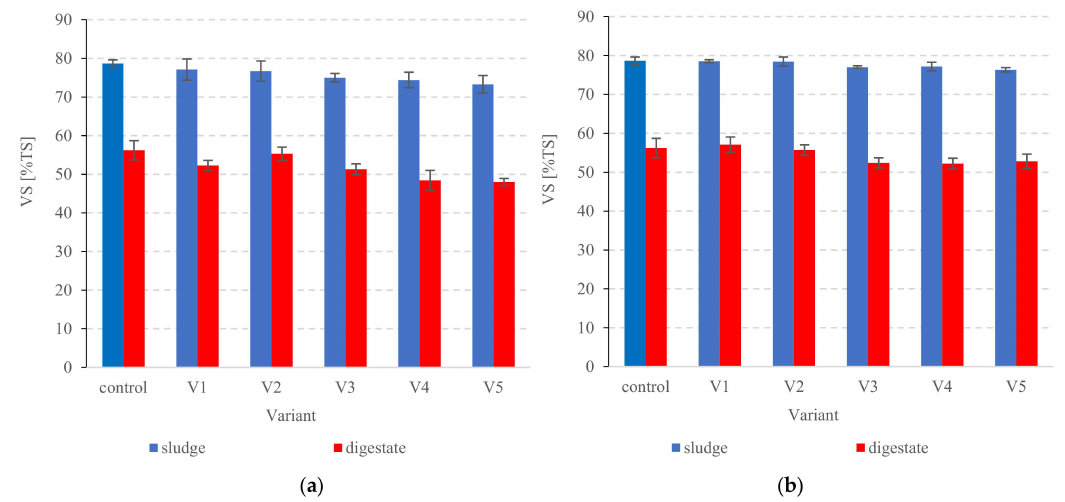
Figure 9. VS in the sludge and digested PSS in ( a ) series 1, ( b ) series